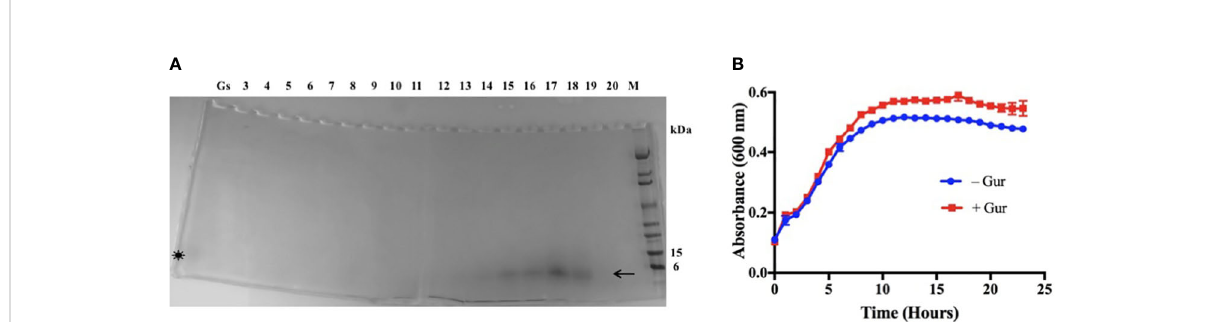
FIGURE 1 Puri fi cation of bio fi lm inhibitory polypeptide from Gs leaf extract fraction and growth of Sa in the presence of polypeptide. (A) The active principle of Gs leaf extract (water-ethanol, 1:1) was subjected to preparative IEF as described. Aliquots of samples from IEF fractions (3-20) were separated on SDS-PAGE (4-20%) under reduced conditions and Coomassie blue stained. Migration of the stained polypeptide (~4.2 kDa) is shown (arrow, #14-18) below to the 6 kDa protein standard. Original active fraction (Gs) was included during SDS-PAGE, and a weakly stained diffuse polypeptide band can be seen (asterisk). (B) Growth of Sa without or with puri fi ed polypeptide (15 µg/ml) in TSB at 37°C. The puri fi ed polypeptide increased slightly the growth rate of Sa at late exponential phase under the conditions